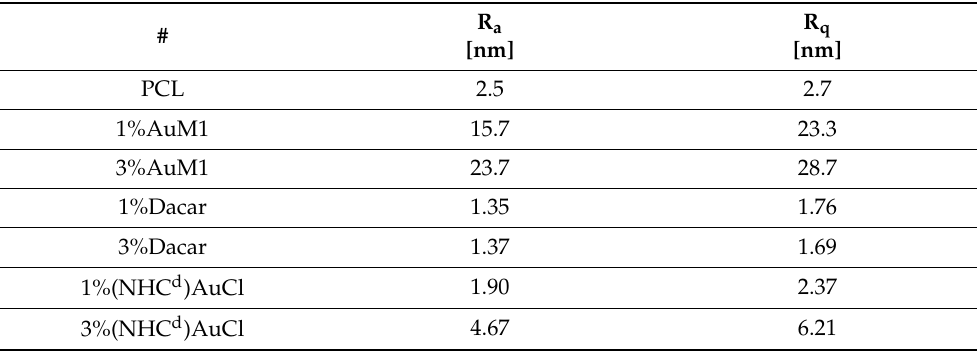
Table 1. Roughness parameters evaluated for the various